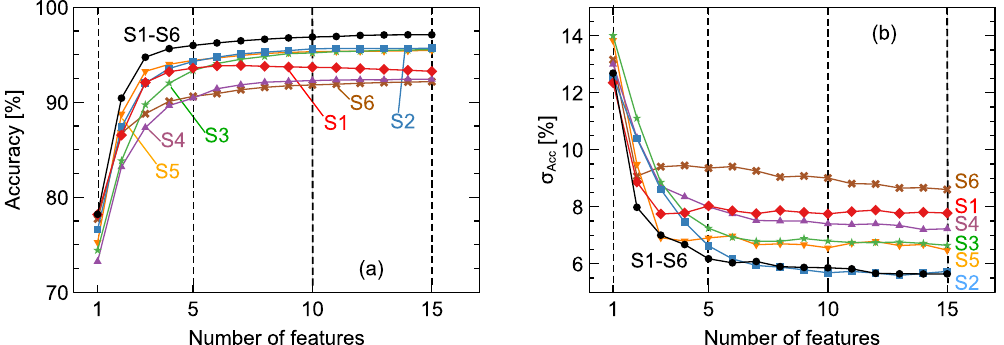
Figure 5. Average model accuracy ( a ) and standard deviation σ Acc ( b ) versus the number of features selected by the recursive forward selection method. Comparisons of models built on data from all sensors (S1–S6) with models trained on data from a single sensor (S1, ..., S6). Lines are drawn as a guide for the